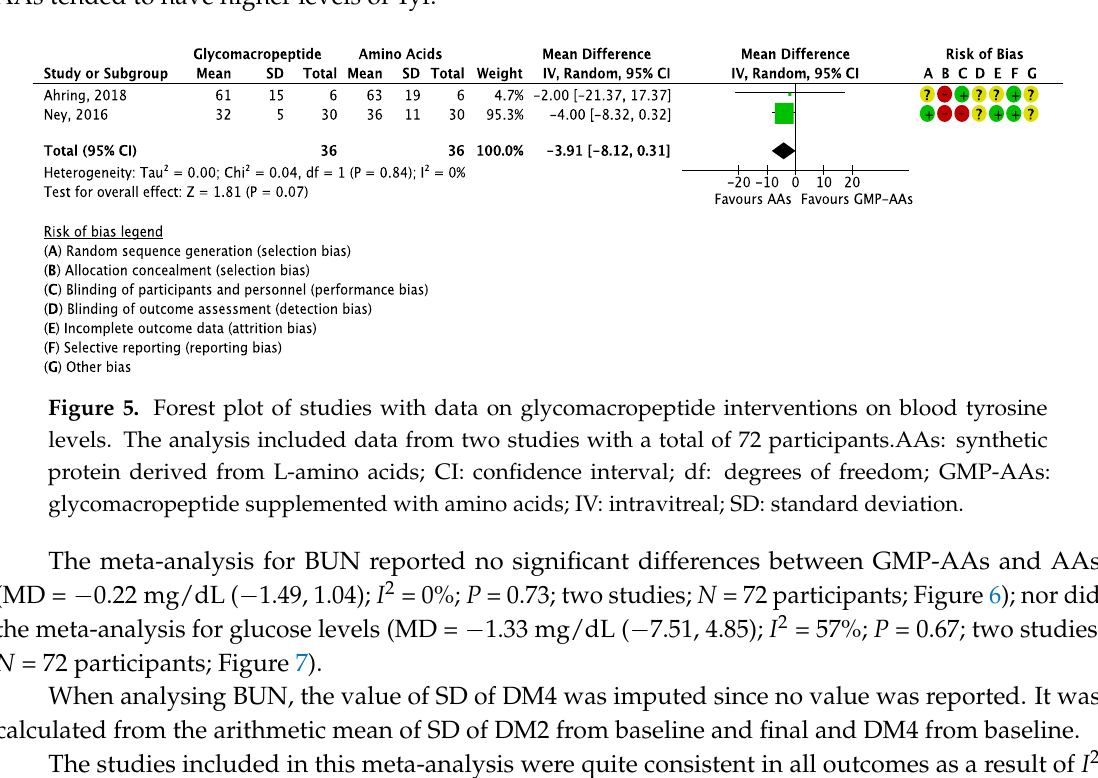
Figure 6. Forest plot of studies with data on the effect of glycomacropeptide interventions on blood urea nitrogen. The analysis included data from two studies with a total of 72 participants.AAs: synthetic protein derived from L-amino acids; CI: confidence interval; df: degrees of freedom; GMP- AAs: glycomacropeptide supplemented with amino acids; IV: intravitreal; SD: standard deviation. Figure 7. Forest plot of studies with data on the effect of glycomacropeptide interventions on glucose levels. The analysis included data from two studies with a total of 72 participants. AAs: synthetic protein derived from L-amino acids; CI: confidence interval; df: degrees of freedom; GMP-AAs: glycomacropeptide supplemented with amino acids; IV: intravitreal; SD: standard deviation.